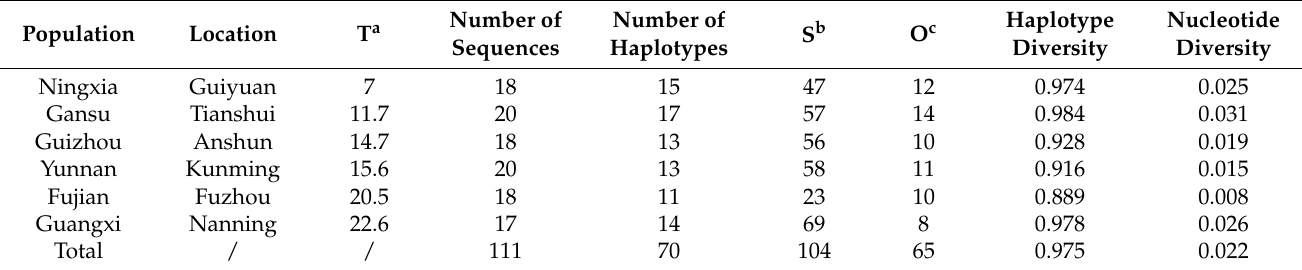
Table 1. Annual mean temperature and summary statistics of genetic diversity in Avr1 of six Phytophthora infestans populations sampled from